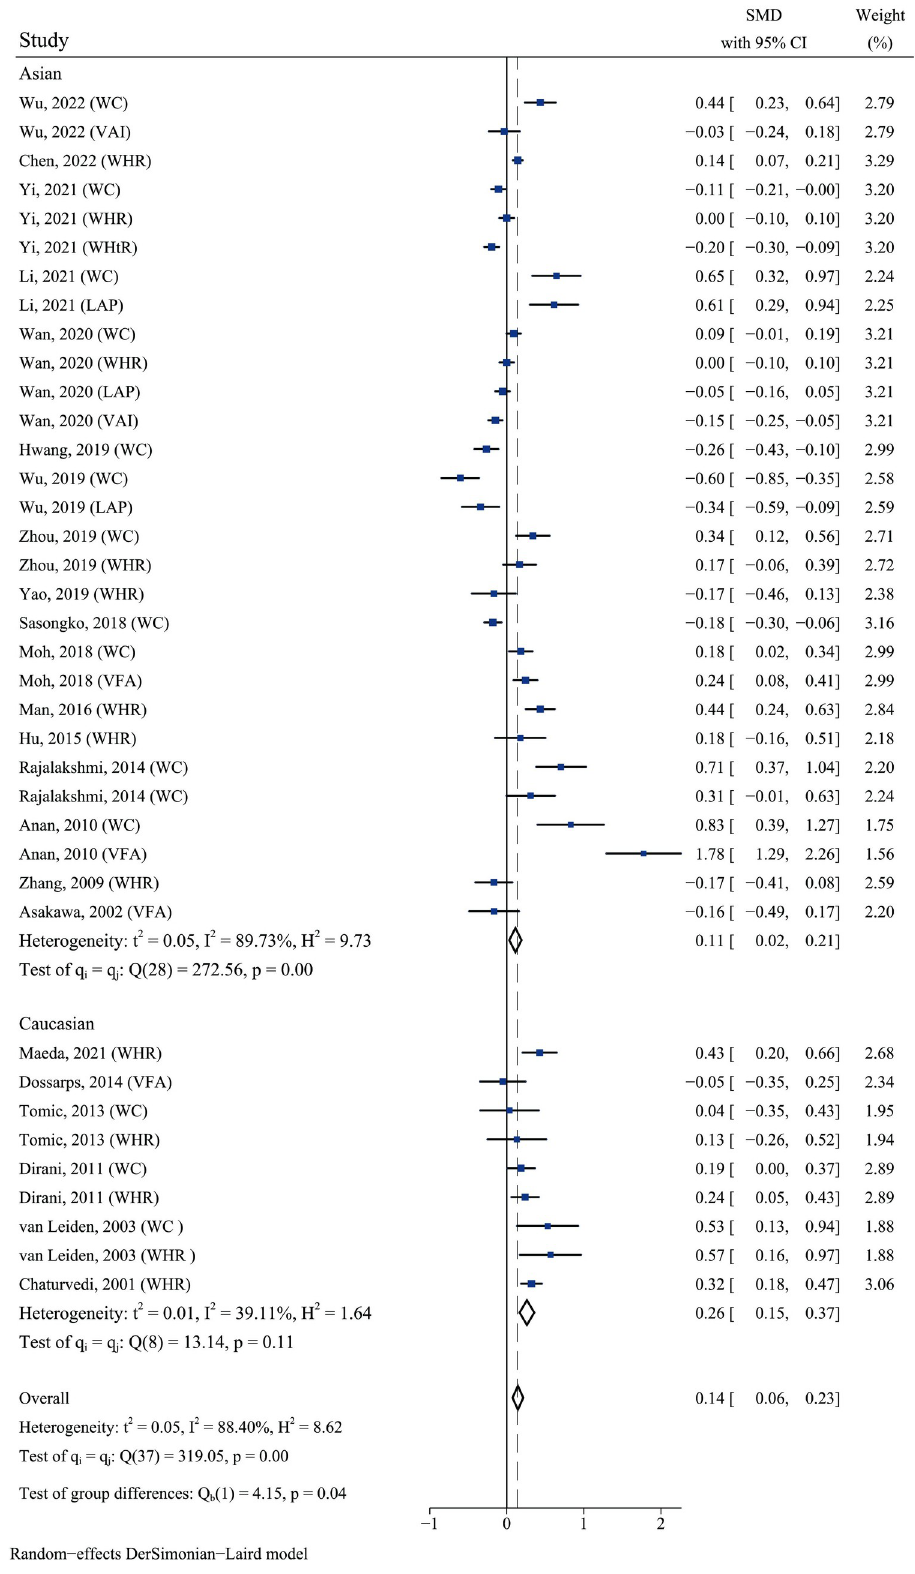
Fig 6. Forest plot of the association between abdominal obesity and DR in different ethnic subgroups. https://doi.org/10.1371/journal.pone.0279734.g006 PLOS ONE | https://doi.org/10.1371/journal.pone.0279734 January 5,